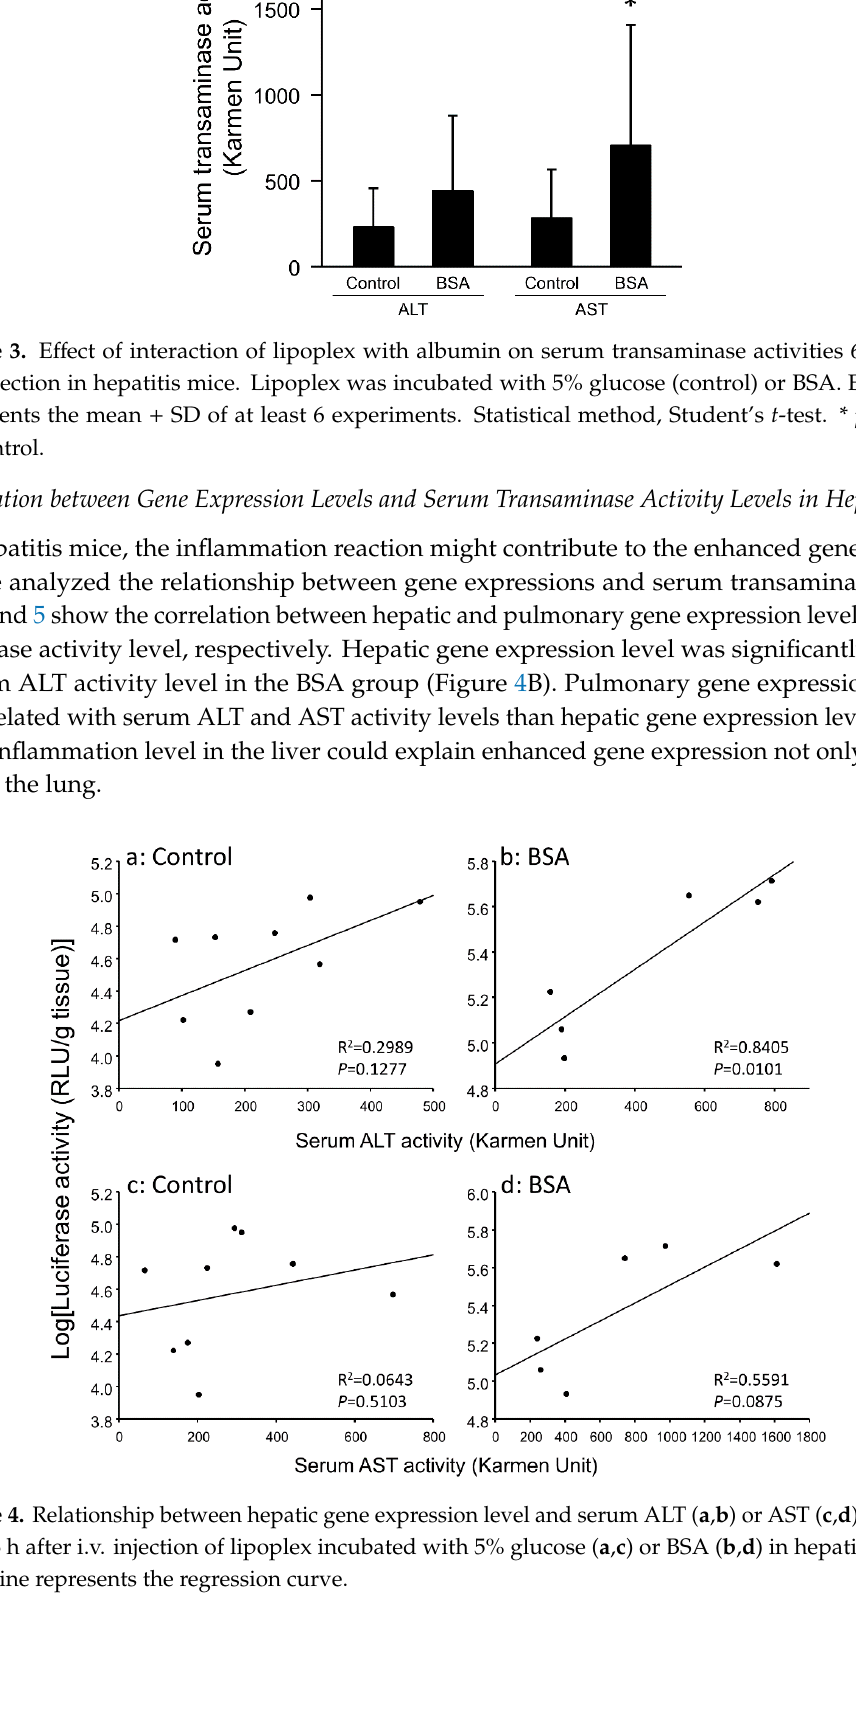
Figure 5. Relationship between pulmonary gene expression level and serum ALT ( a , b ) or AST ( c , d ) activity level 6 h after i.v. injection of lipoplex incubated with 5% glucose ( a , c ) or BSA ( b , d ) in hepatitis mice. Solid line represents the regression curve.